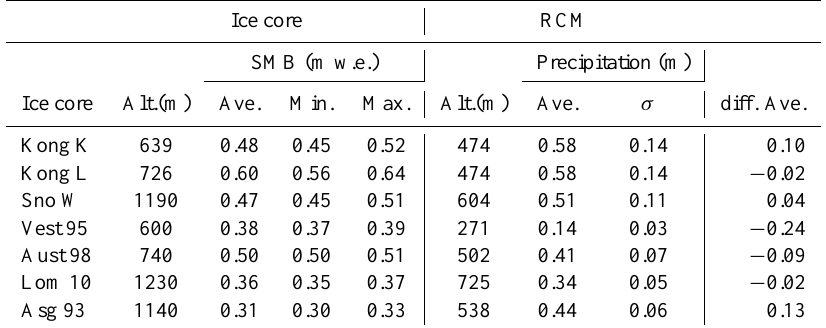
Table 2. Specific net SMB average, minimum and maximum estimates from ice cores and RCM annual total precipitation and standard deviation. The altitude of the ice core location, the RCM grid cell orographic height and the difference between RCM precipitation and ice core accumulation are included.